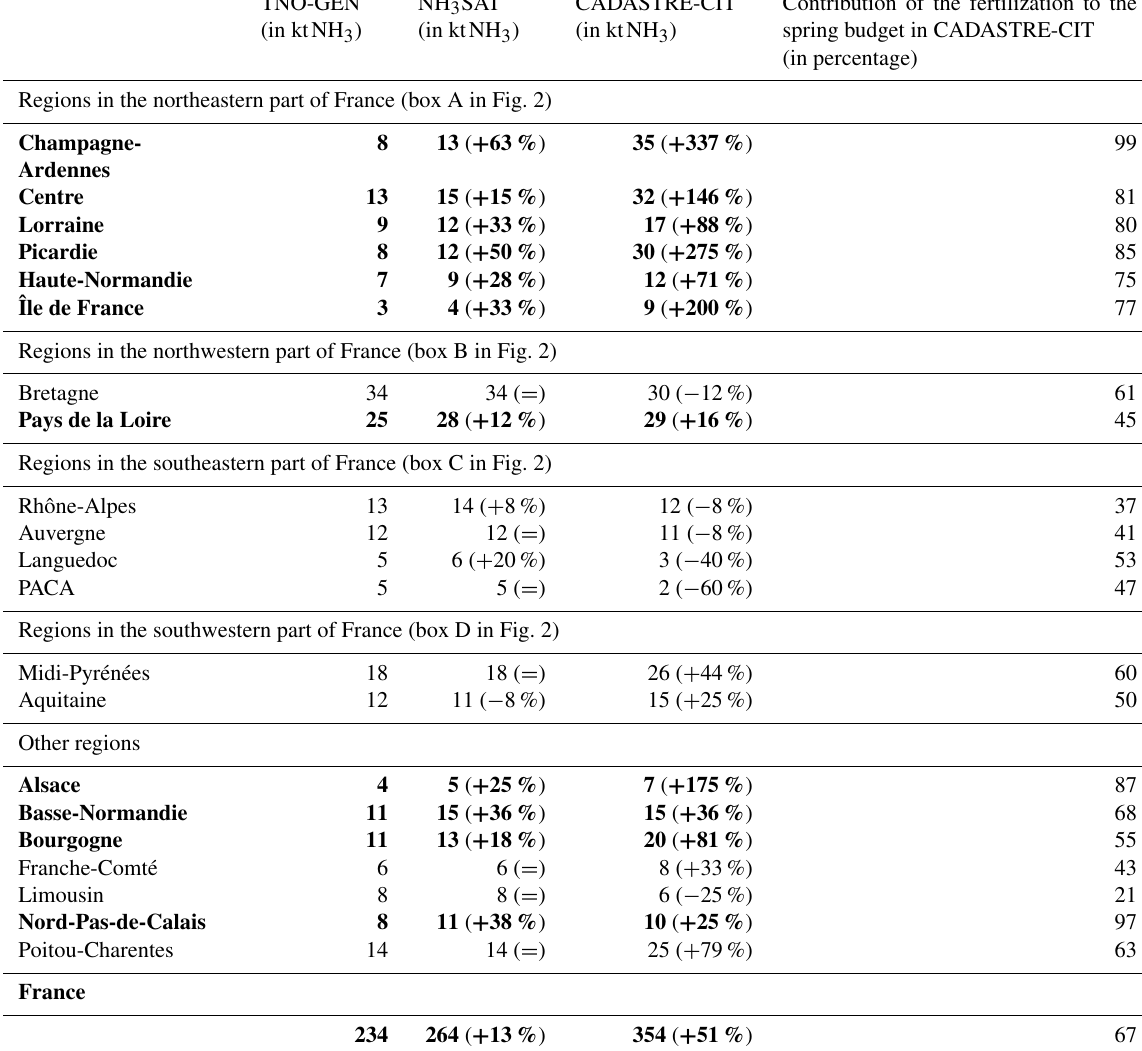
Table 2. French national and regional budgets of NH 3 spring emissions, from March to May 2011, in kilotons of NH 3 (ktNH 3 ). The relative differences compared to the TNO-GEN are presented between brackets, in percentage. Regions for which the inventories NH 3 SAT and CADASTRE-CIT propose the same sign of relative differences are marked in bold. The contributions of the fertilization emissions to the NH 3 regional spring budget in the CADASTRE-CIT inventory are shown in percentage.